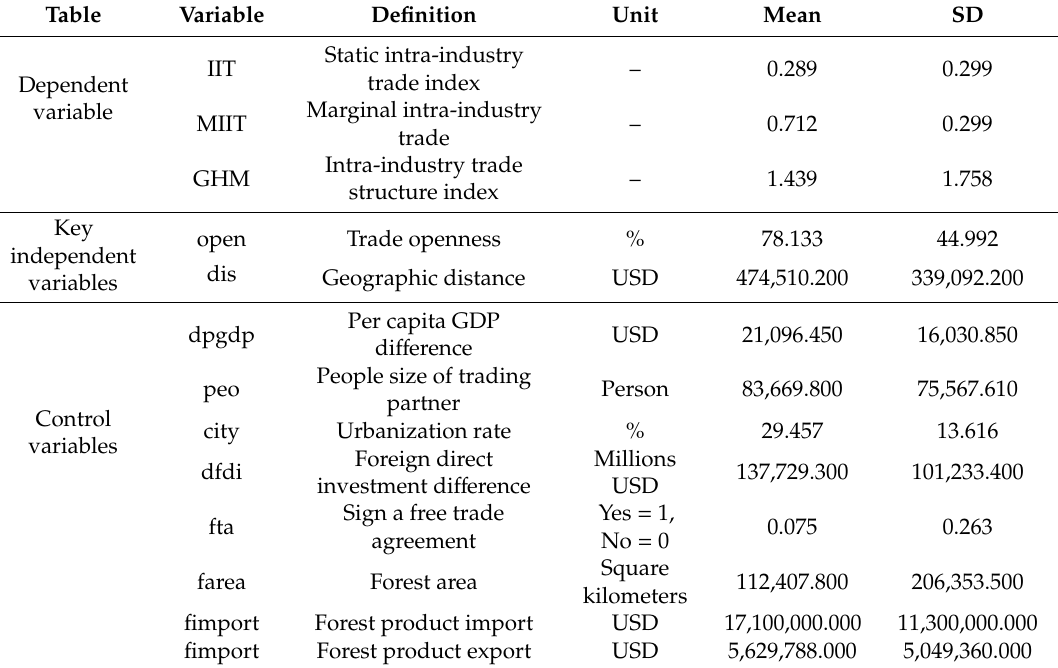
Table 2. Variable statistics and expected impact